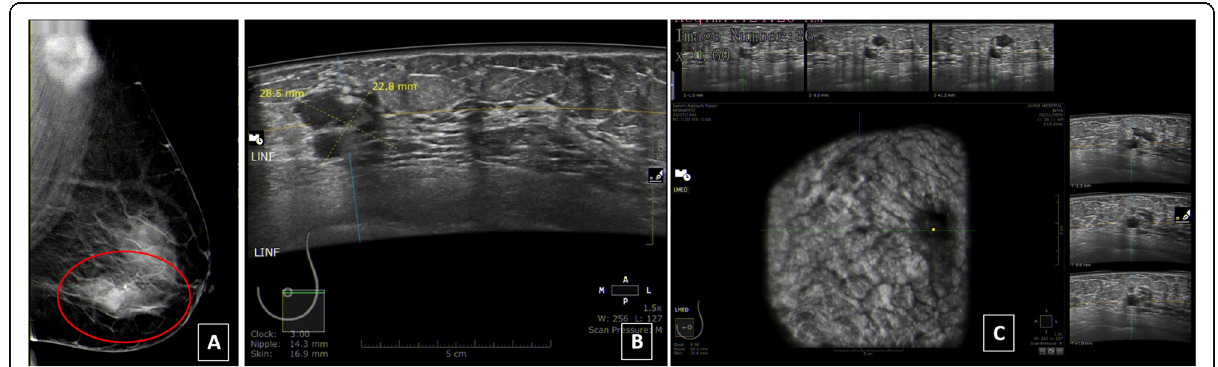
Fig. 4 Case four: 55-year-old female with left breast lump A Tomo MLO slice showing a dense spiculate mass with obscured margins (circle). B , C ABUS images in multiplanar views showing the mass to be multifocal hypoechoic with ill-defined margins. US-guided core biopsy revealed multifocal IDC with